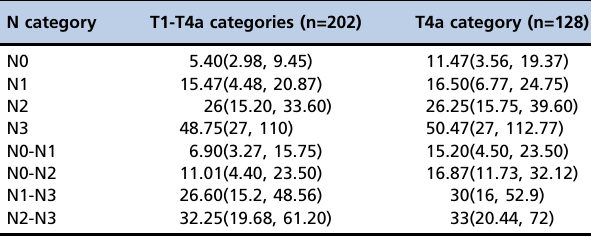
Table 2 - Gross tumor volume of resectable gastric adenocarcinoma in patients stratified by N